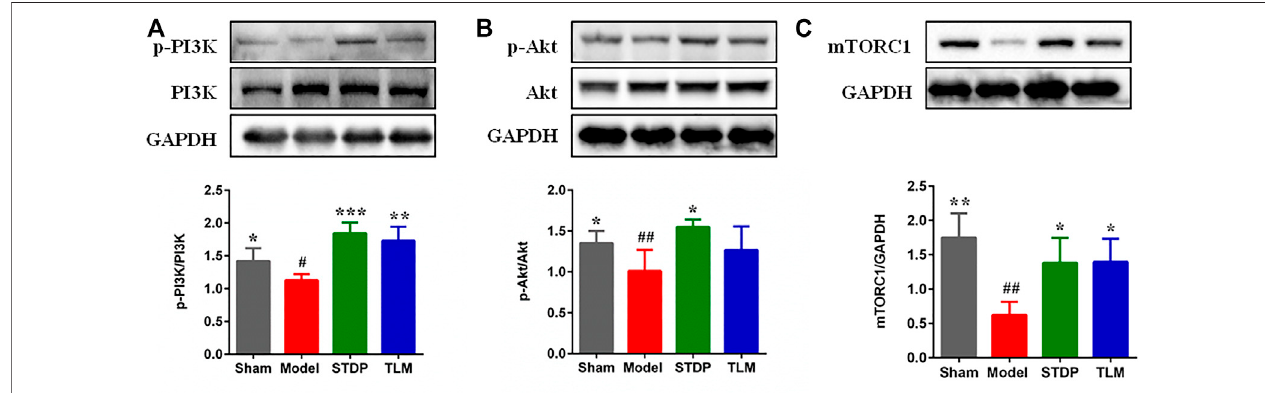
FIGURE 3 | STDPs upregulated the PI3K/Akt/mTORC1 pathway in ischemic heart of rats. (A – C) Representative immunoblots and analysis for p-PI3K, p -Akt, and mTOCR1 in the sham, model, STDP, and TLM groups. N = 3 per group. * p < 0.05, ** p < 0.01, *** p < 0.001 vs . the model group; # p < 0.05, # # p < 0.01 vs . the sham